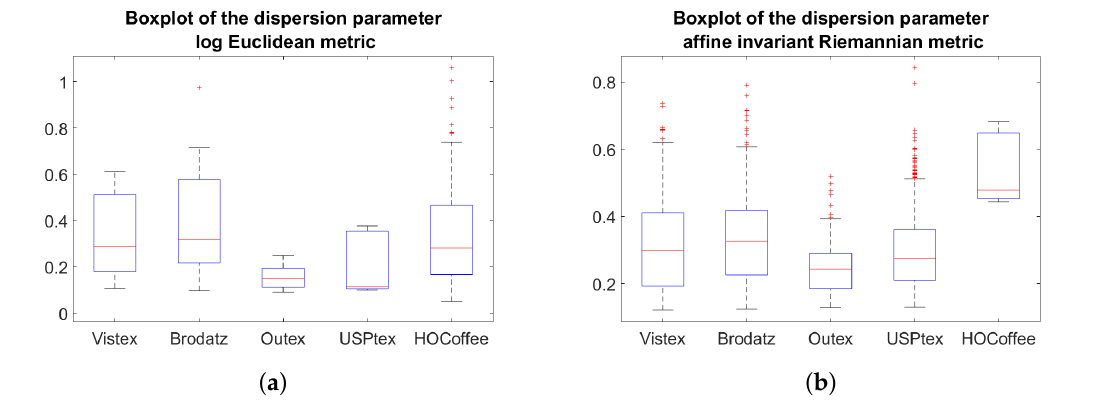
Figure 6. Boxplots of the dispersion parameter for the codebook computed with ( a ) the LE and ( b ) the affine invariant Riemannian